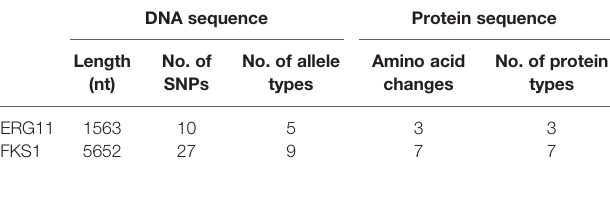
TABLE 3 | The variability of ERG11 and FKS1 genes in clinical Diutina catenulata isolates. DNA sequence